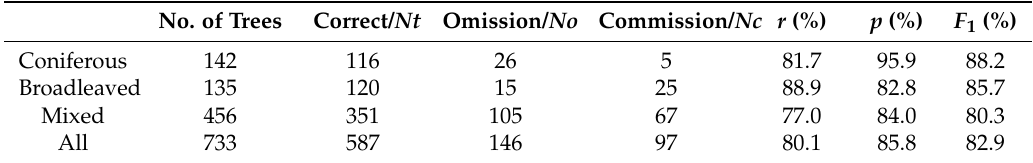
Table 5. The accuracy assessment of individual tree detection.